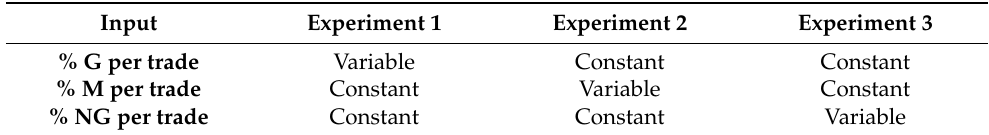
Table 8. Inputs of simulation experiments. Input Experiment 1 Experiment 2 Experiment 3 % G per trade Variable Constant Constant % M per trade Constant Variable Constant % NG per trade Constant Constant